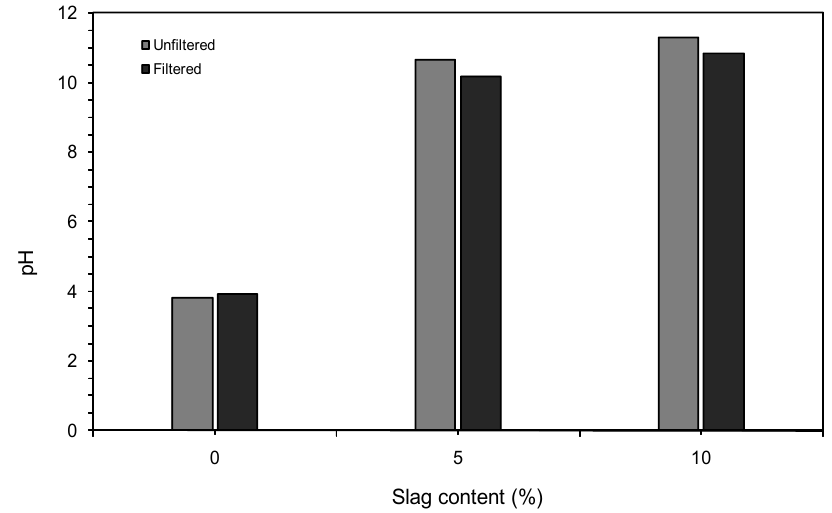
Fig. 6. pH of leachate for 0%, 5% and 10% BOS slag